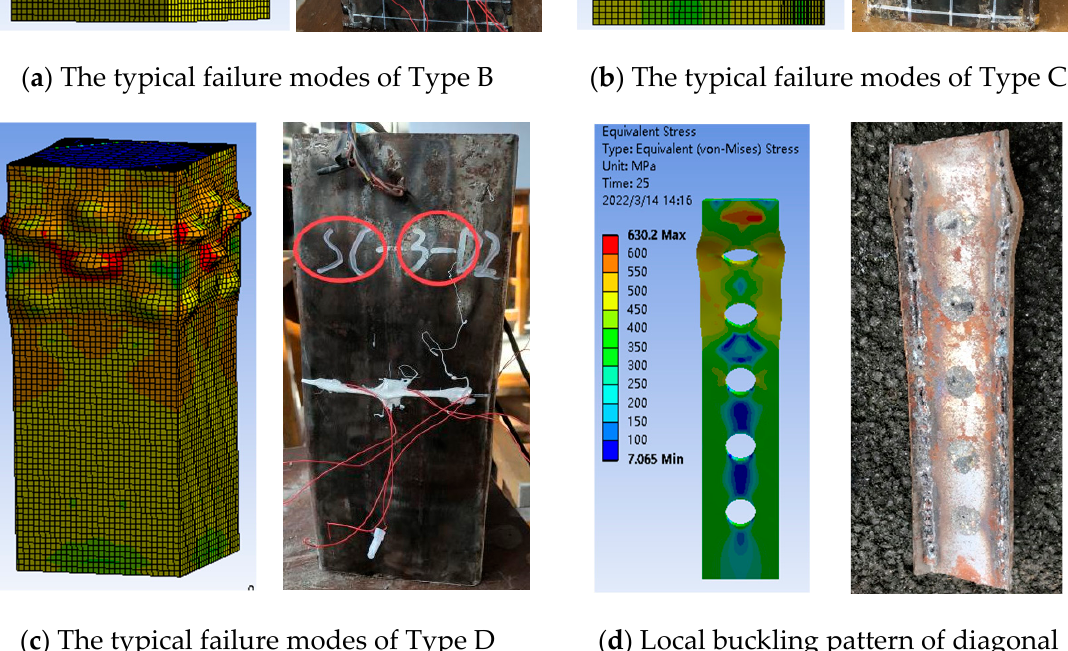
Figure 12. Comparison of typical failure modes between FEA and Test.